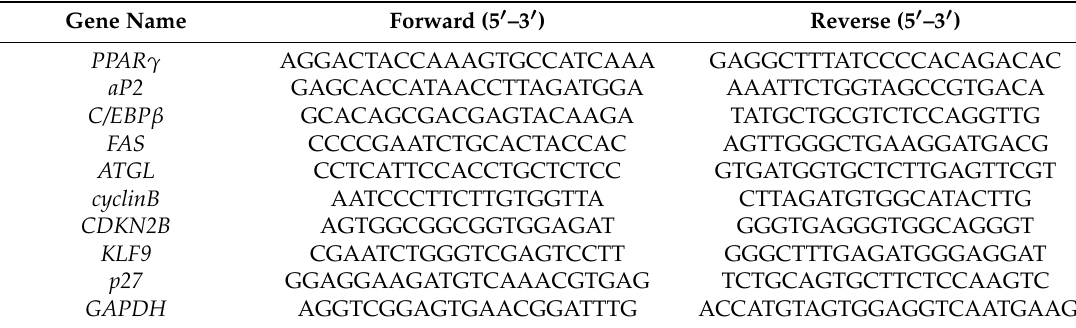
Table 1. Primer sequences used in this